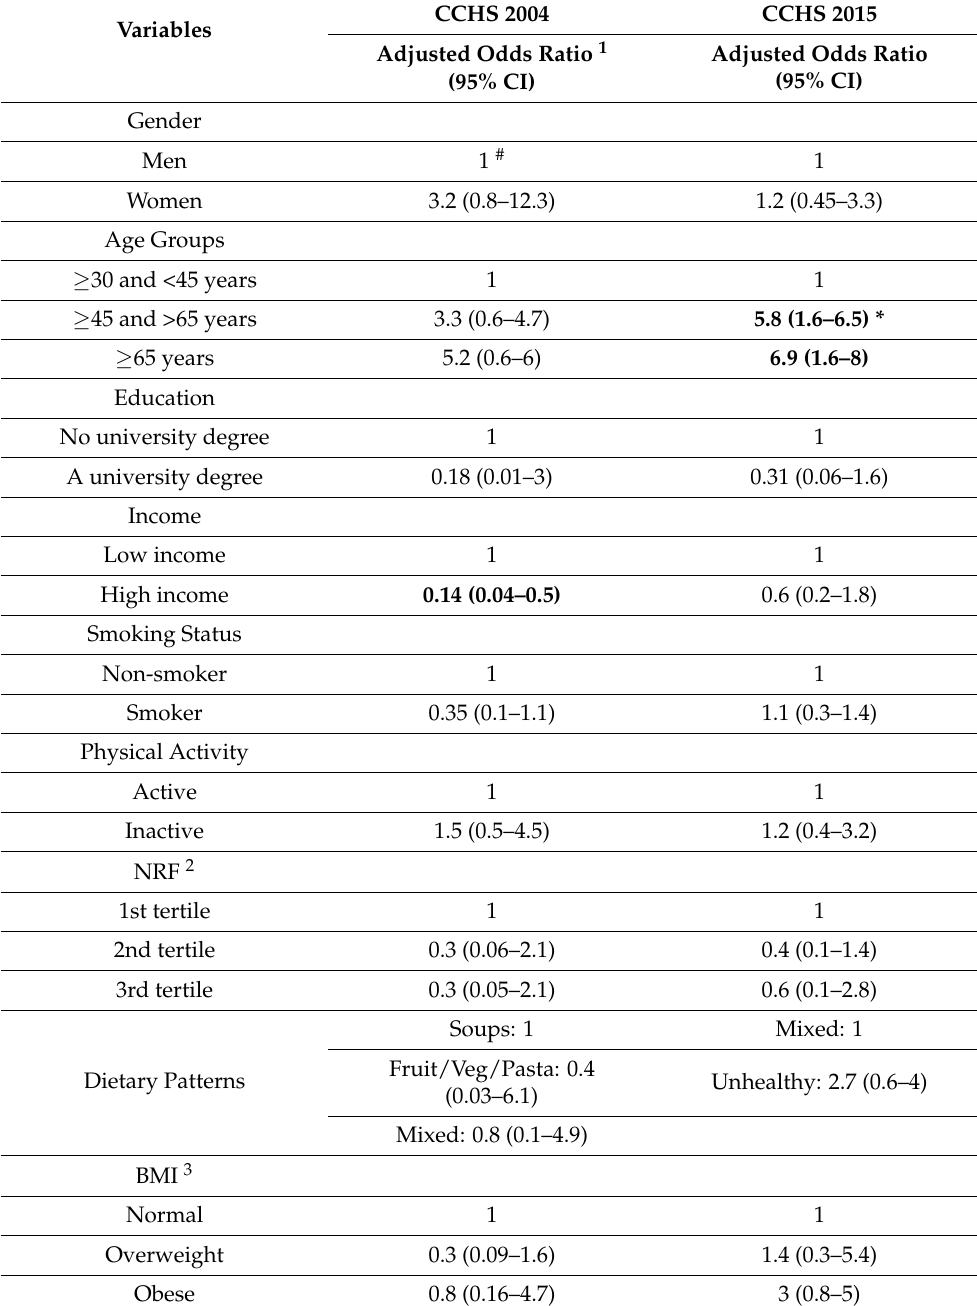
Table 5. Factors associated with chronic diseases among Indigenous